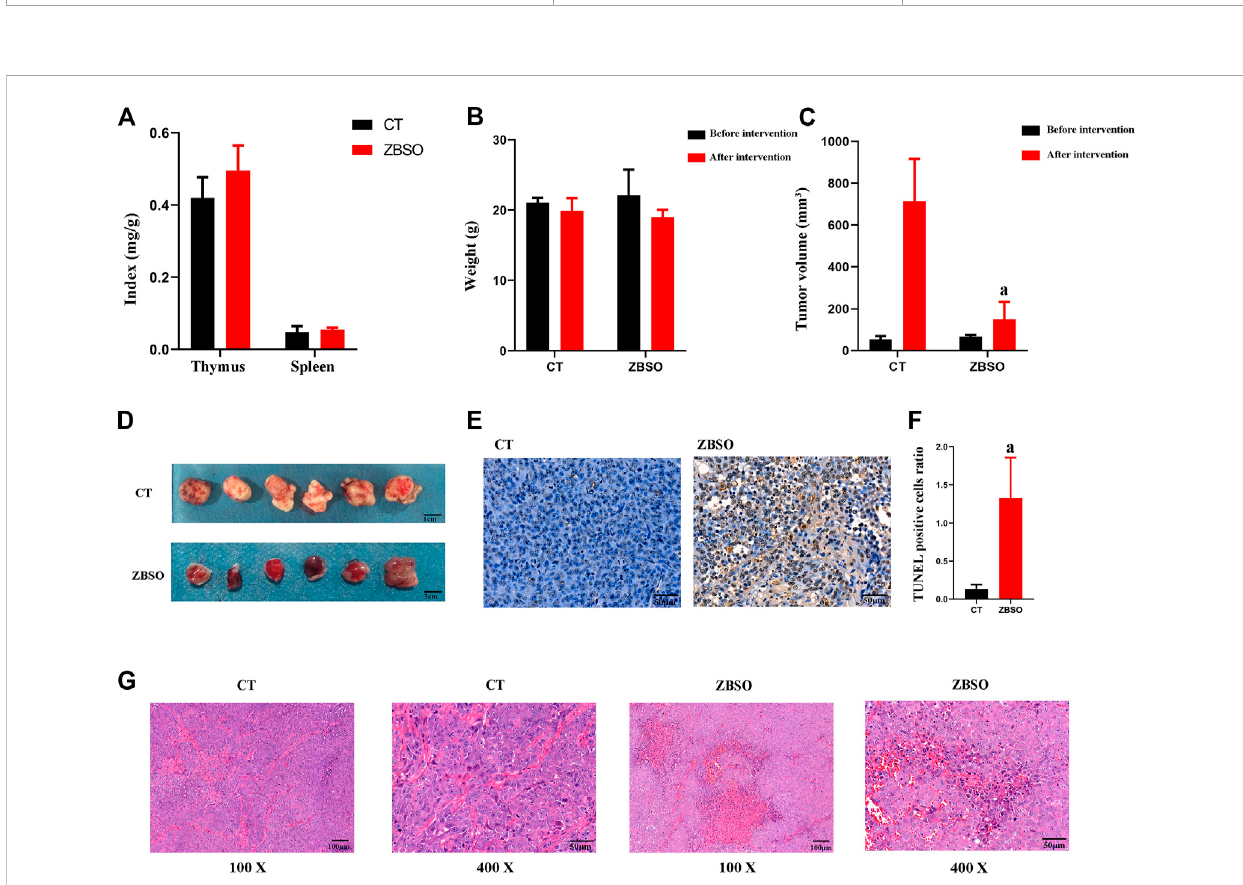
FIGURE 2 Anti-cancer effects of ZBSO in the nude mouse xenograft model of human melanoma. (A) The spleen and thymus index in nude mice. (B) The body weight of nude mice before and after the treatment of ZBSO. (C,D) The tumor volume of nude mice before and after the treatment with ZBSO. (E,F) The TUNEL stained sections of xenograft tumor tissue from control and ZBSO groups of nude mice, at ×400 magni fi cation. Scale bar 50 μ m. (G) The HE- stained sections of xenograft tumor tissue from control and ZBSO groups of nude mice, at 100 × (Scale bar 100 μ m) and 400 × (Scale bar 50 μ m) magni fi cation ( a p < 0.05 compared with control